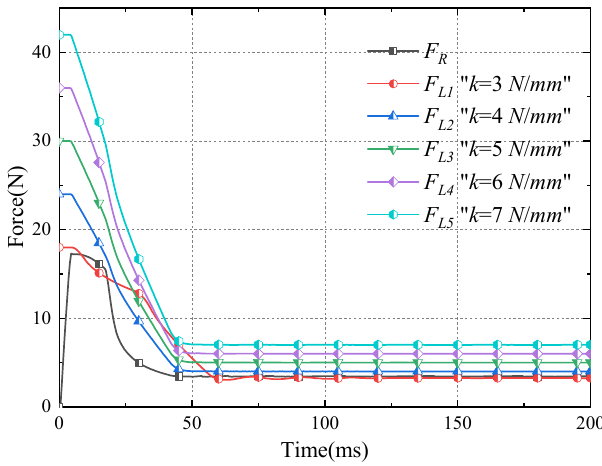
Figure 20 . The dynamic change process of F L and F R . Figure 20. The dynamic change process of F